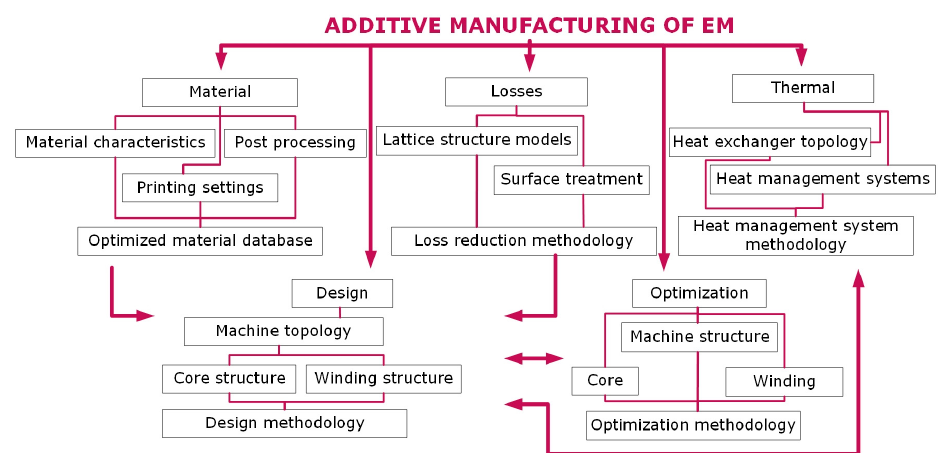
Figure 2. Interconnection of fields in need of methodological advancement and further research. It is highly likely that the additive manufacturing of electrical machines will, at first, remain a niche product, until the multi-material printing technology becomes faster and more available for a larger community of engineers and researchers. However, it has to be considered that the development of additive manufacturing systems is very fast and it is only a question of time before the additive manufacturing of electrical machines will reach the mainstream. For this to happen, there must be significant effort and input made by the scientific community in order to mature the technologies and methodologies enough to meet industrial needs.